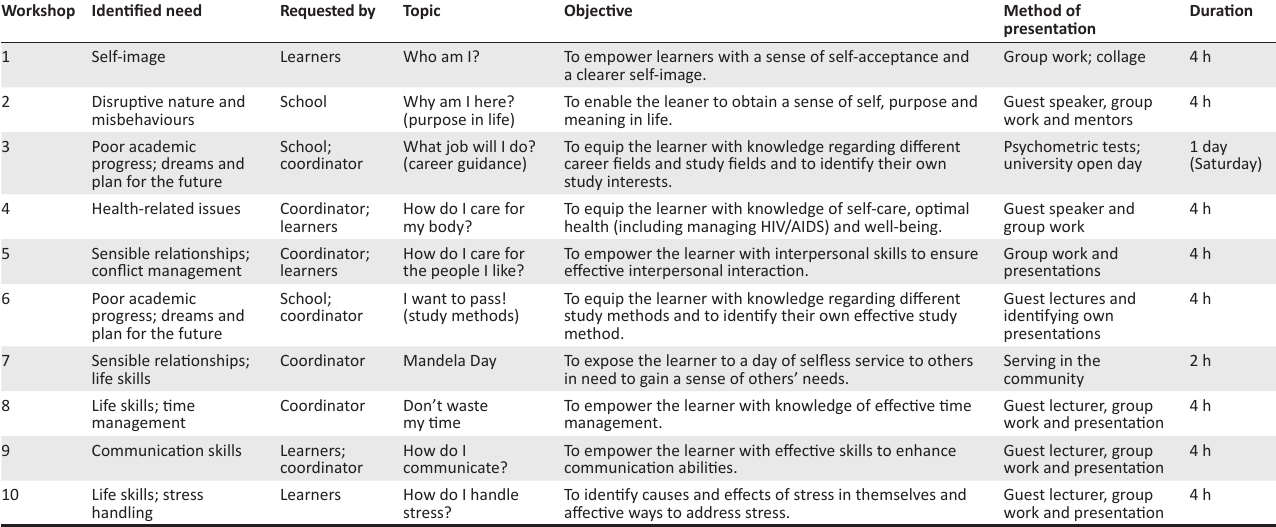
TABLE 4: Corporate social responsibility initiative workshop schedule. Workshop Identified need Requested by